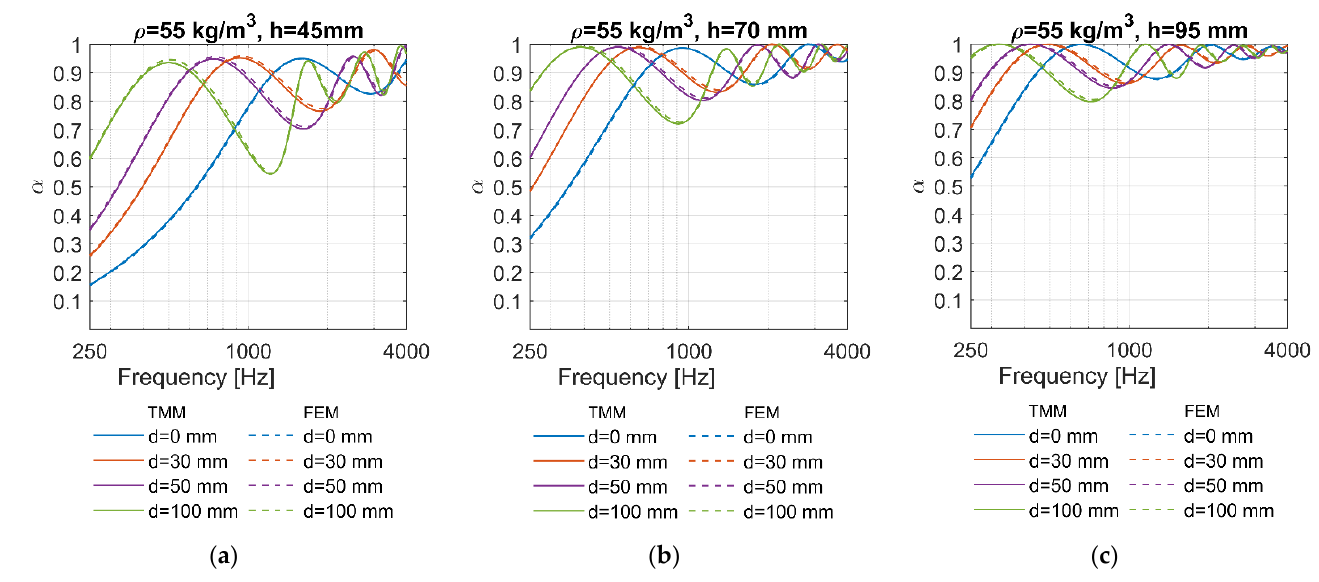
Figure 13. Sound absorption coefficients for different air gap thicknesses, ρ = 55 kg/m 3 .